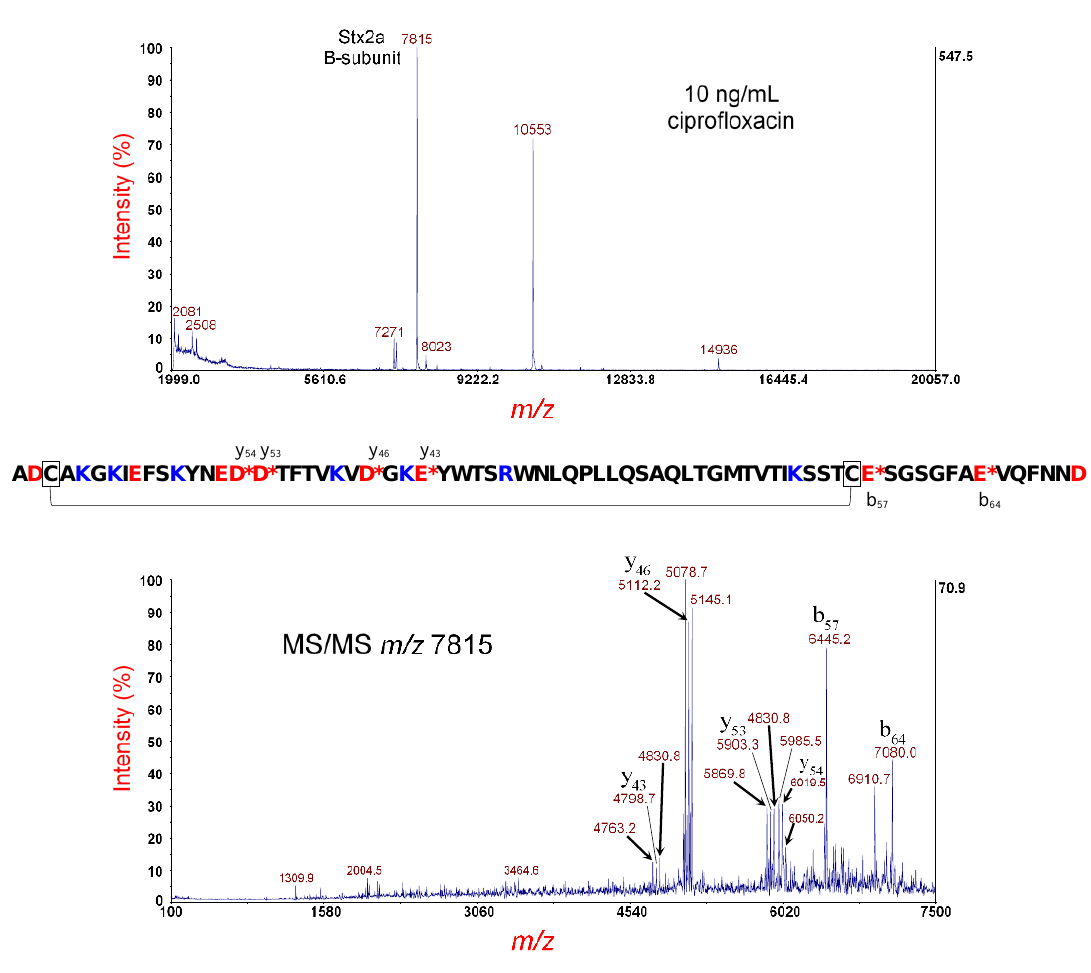
Figure 1. Top panel: MS analysis of E. coli O157:H- strain 493/89 cultured overnight on LBA supplemented with 10 ng/mL of ciprofloxacin. The putative disulfide-bond-intact B-subunit of Stx2a is indicated. Bottom panel: MS/MS analysis of the putative B-subunit at m/z 7815 in the top panel. Fragment ions are indicated by their m/z and b- or y-type designations. The sequence of the Stx2a B-subunit is shown. A red asterisk indicates sites of polypeptide backbone cleavage that generate the corresponding fragment ions shown above (y-type) or below (b-type) the sequence. Acidic residues are highlighted in red and basic residues in blue. Cysteine residues are boxed, and a connector line symbolizes the intramolecular disulfide